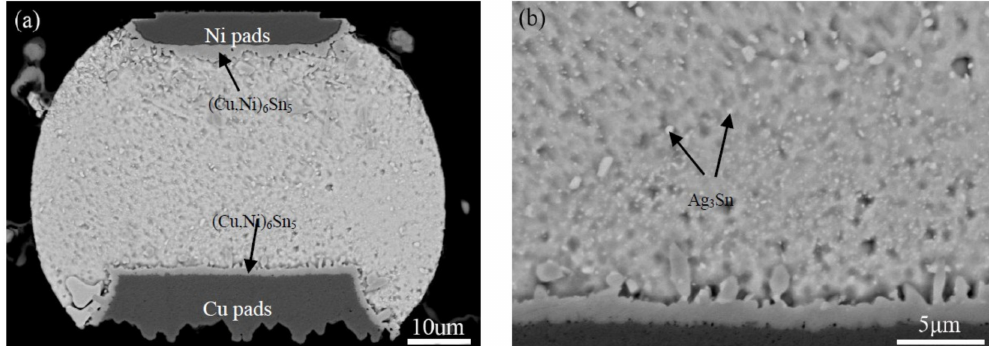
Figure 2. Across-sectional back-scattered electron (BSE) image of the corner SAC305 micro-joint in flip chip assembly after assembly reflow: ( a ) Entire solder joint; ( b ) local magnified image around Ni pad. Table 2. Energy-dispersive x-ray spectrometry (EDS) compositional analysis of intermetallic compounds (IMCs) phases formed in a Cu/SAC305/Ni micro-joint. Composition Analysis Sites